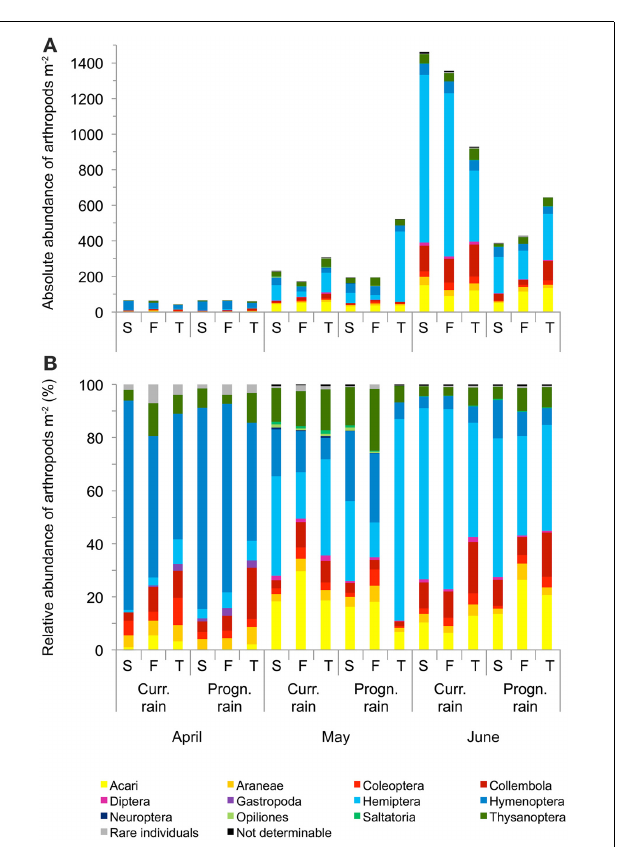
FIGURE 4 | Mean absolute (A) and relative (B) abundance of arthropods per m 2 at the three sampling dates in winter wheat cultivated under current and prognosticated rainfall variations at the different soil types calcaric phaeozem (S), gleyic phaeozem (F) and calcic chernozem (T).